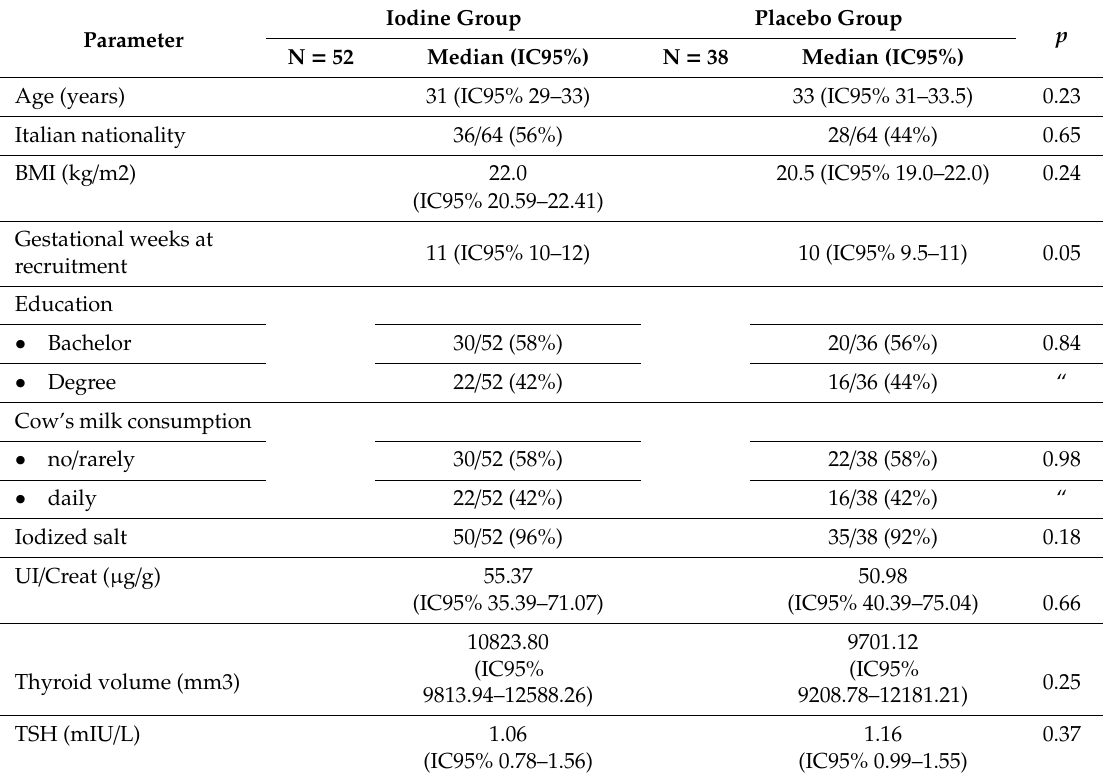
Table 1. Patients’ characteristics at the